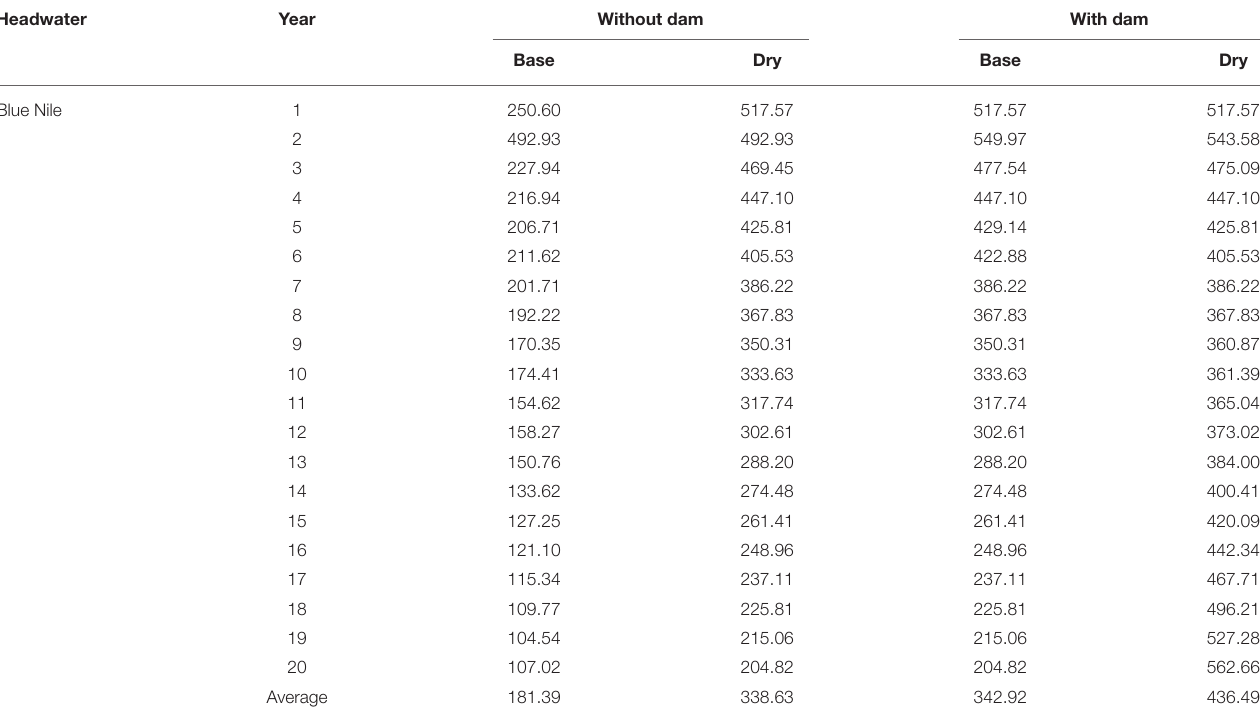
TABLE 5 | Hydroeconomic model results illustration—economic value of one additional unit of water (shadow price) at Blue Nile headwater region above grand renaissance ethiopian dam, by year, policy, and climate scenario ($US Per 1,000 cubic meters).